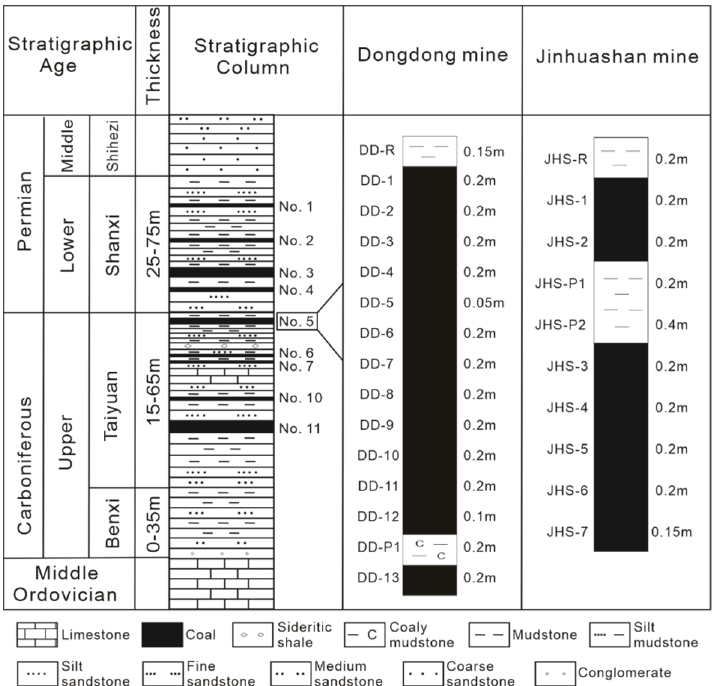
Figure 2. Stratigraphic columnof Permo-Carboniferous coal-bearing strata in the Weibei Coalfield and sampling distributionin the No. 5 coal seam of the Dongdong and Jinhuashan underground coal mine.